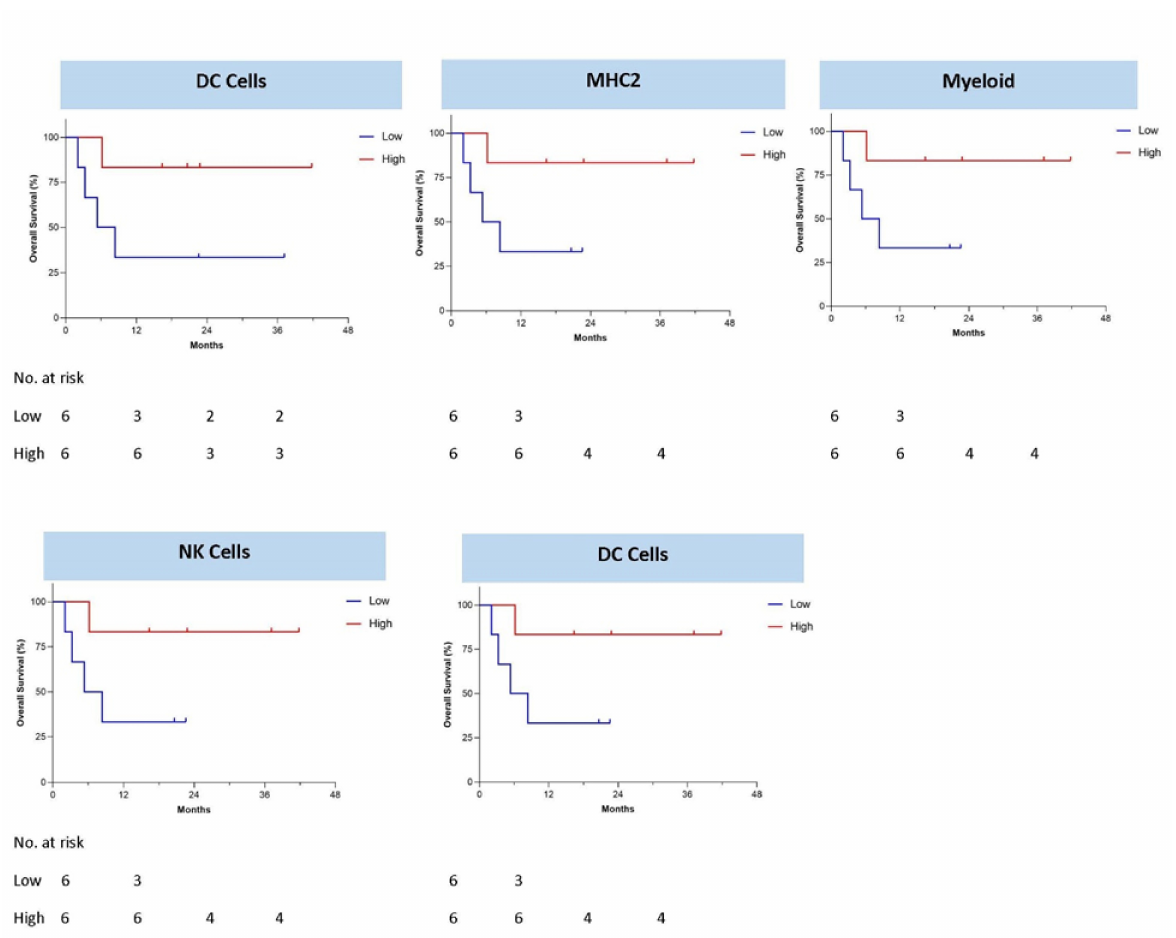
Figure 6. Baseline gene signatures correlate with overall survival after Vigil treatment.